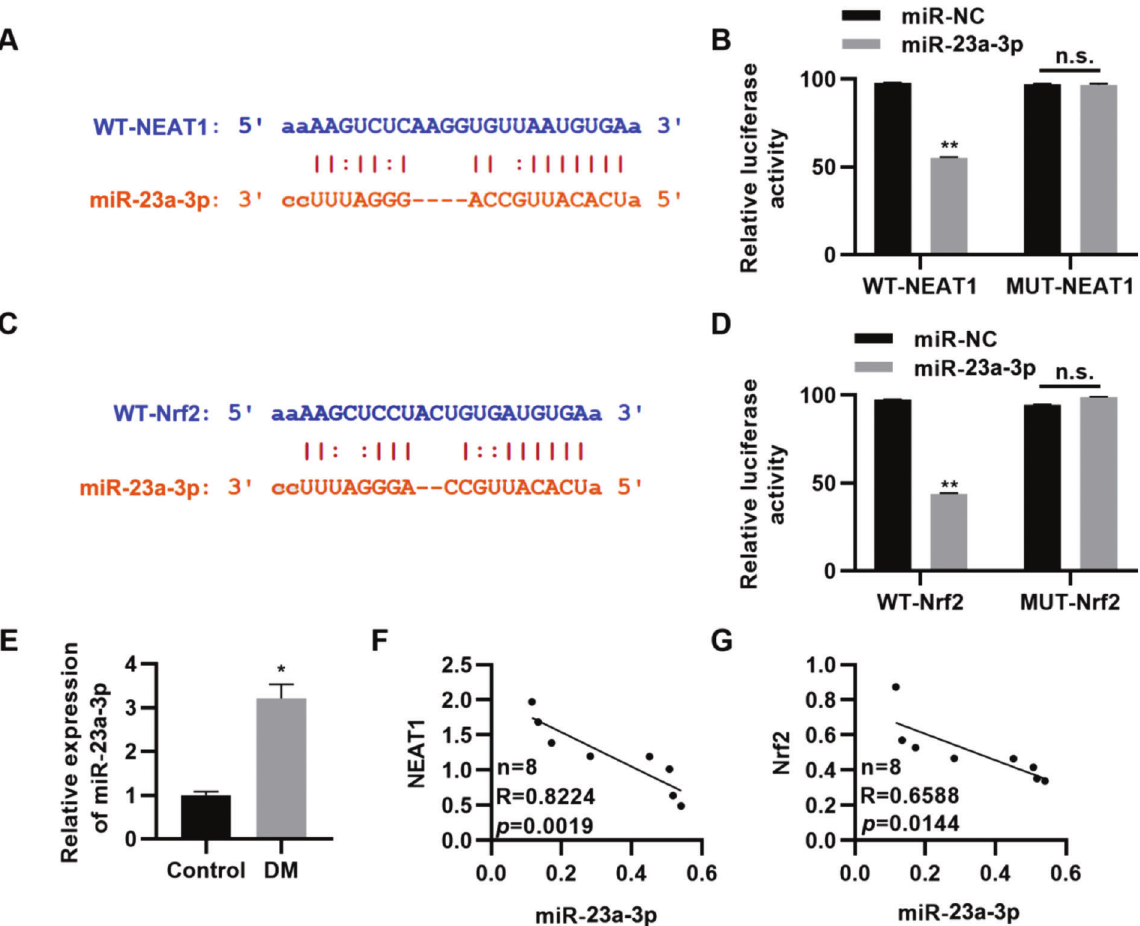
Figure 4 - NEAT1 regulates the expression of Nrf2 by targeting miR-23a-3p . A, Identification of a binding site between NEAT1 and miR-23a-3p ; B, Dual luciferase reporter assay confirming binding between NEAT1 and miR-23a-3p ; C, Identification of a binding site between Nrf2 and miR-23a-3p ; D, Dual luciferase reporter assay confirming binding between Nrf2 and miR-23a-3p ; E, The expression of miR-23a-3p is upregulated in patients with diabetes mellitus (DM); F-G, The expression levels of miR-23a-3p are negatively correlated with the levels of NEAT1 and Nrf2 . * p o 0.05, ** p o 0.01, Mann-Whitney U